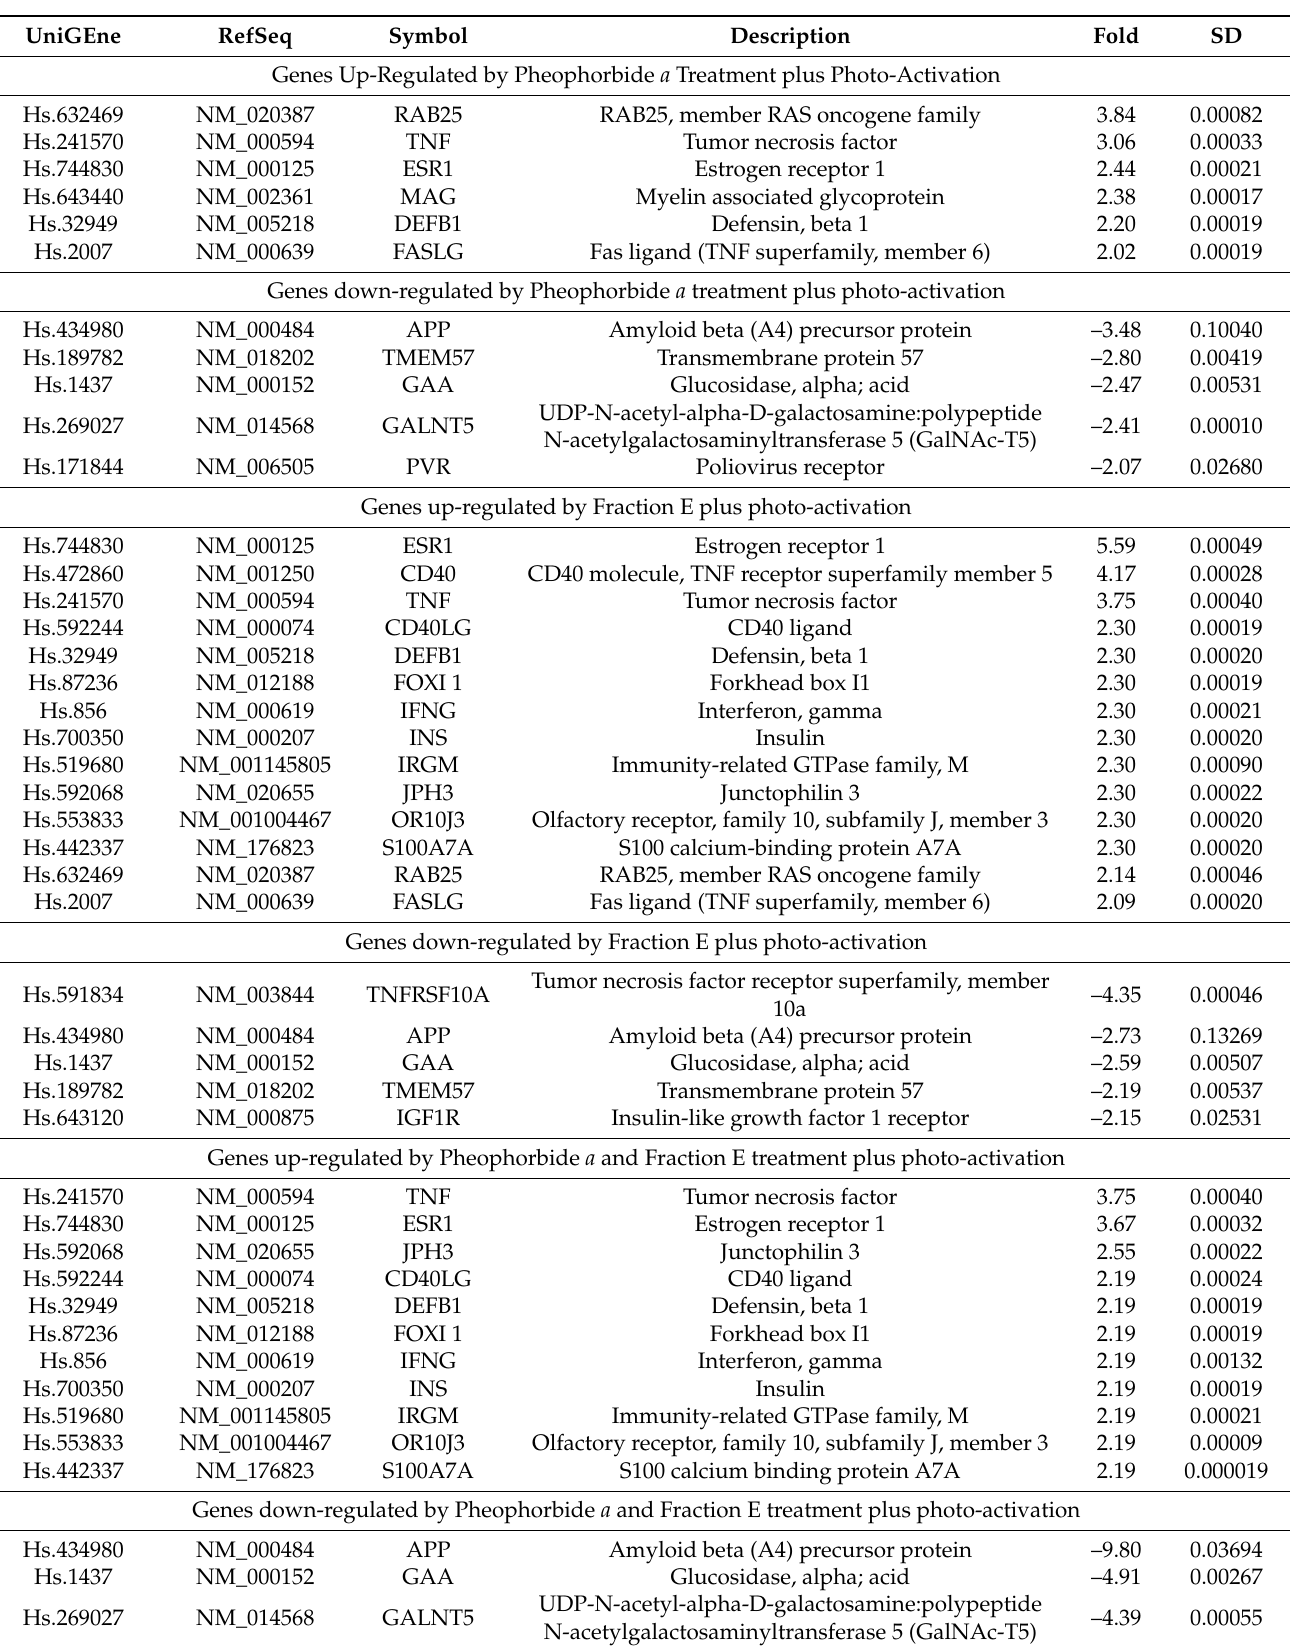
Table 2. Expression levels of cell death-related